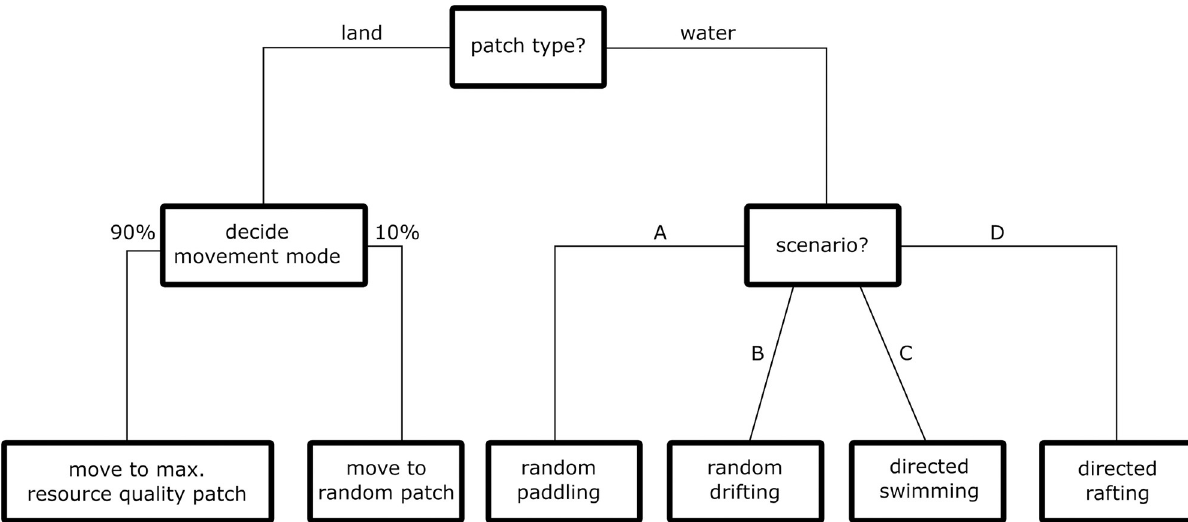
Fig 2. Behavioral decision tree for the scenarios with movement on land (left) and movement in water (right). The movement on land is determined by the resource quality and randomness of the decisions, which is by default set at 10%, whereas the movement in water is determined by the selected